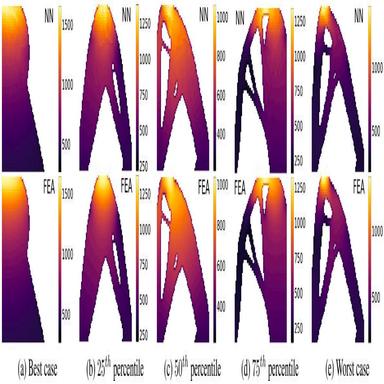
Temperature predictions by ResUNet-based DeepONet compared to FEA for samples in (Rel. 2 Error).